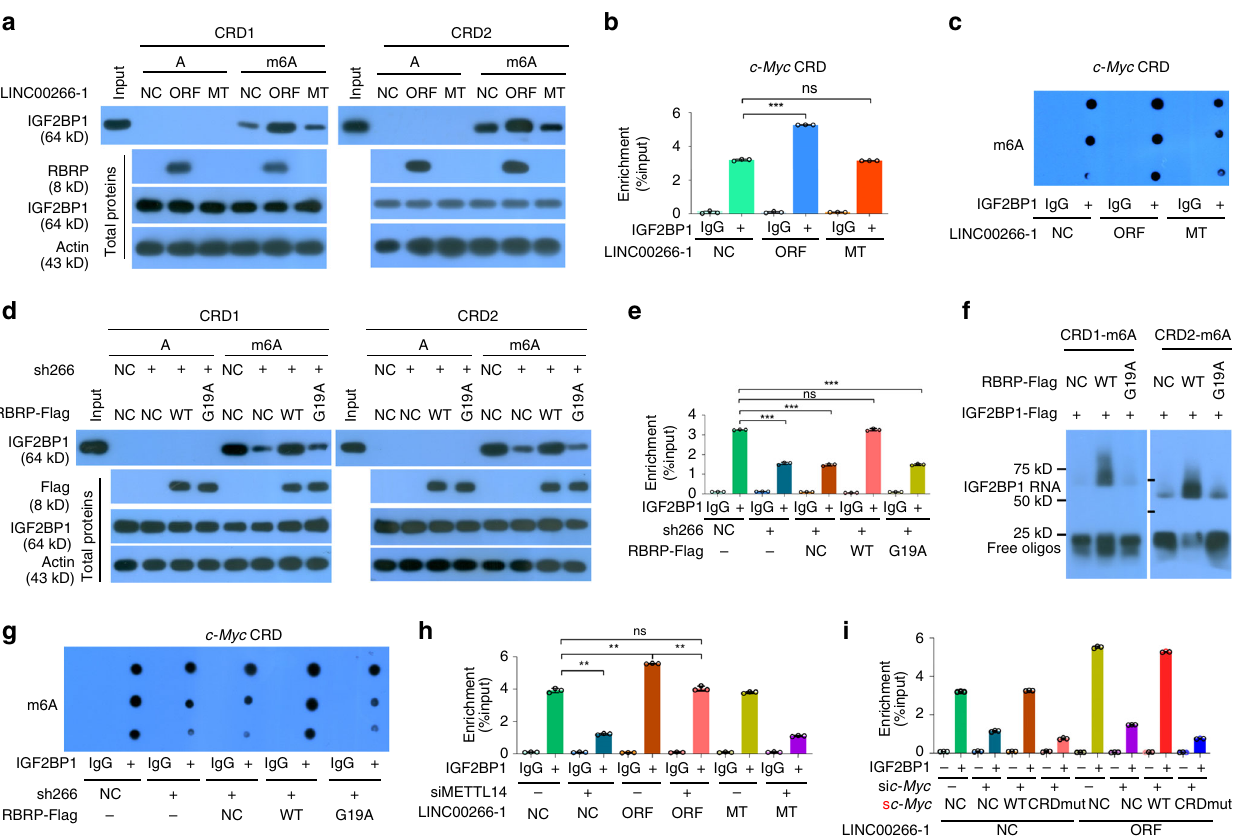
Fig. 5 The RBRP oncopeptide, not the lncRNA LINC00266-1 itself, strengthens the recognition and binding of the m 6 A reader IGF2BP1 to m 6 A- modi fi ed c-Myc CRD mRNA. a The in vitro binding of IGF2BP1 to m 6 A-unmethylated or -methylated c-Myc CRD mRNA oligos was investigated in HCT-116 cells stably expressing the LINC00266-1 ORF or 5 ′ UTR-ORFmut (MT) by RNA pull-down assays. b The in vivo binding of IGF2BP1 on c-Myc CRD mRNA was determined in cells as in a by an RIP-qPCR assay ( n = 3 independent experiments). c The m 6 A levels in IGF2BP1-bound RNAs were detected in cells as in a by dot blotting using an anti-m 6 A antibody. d WT or G19A-mutated RBRP-Flag vectors were transfected into HCT-116 cells with stable knockdown of LINC00266-1 expression (sh266); the in vitro binding of IGF2BP1 to m 6 A-unmethylated or -methylated c-Myc CRD mRNA oligos was analyzed by RNA pull- down assays. e The in vivo binding of IGF2BP1 on c-Myc CRD mRNA was determined in cells treated as in d by an RIP-qPCR assay ( n = 3